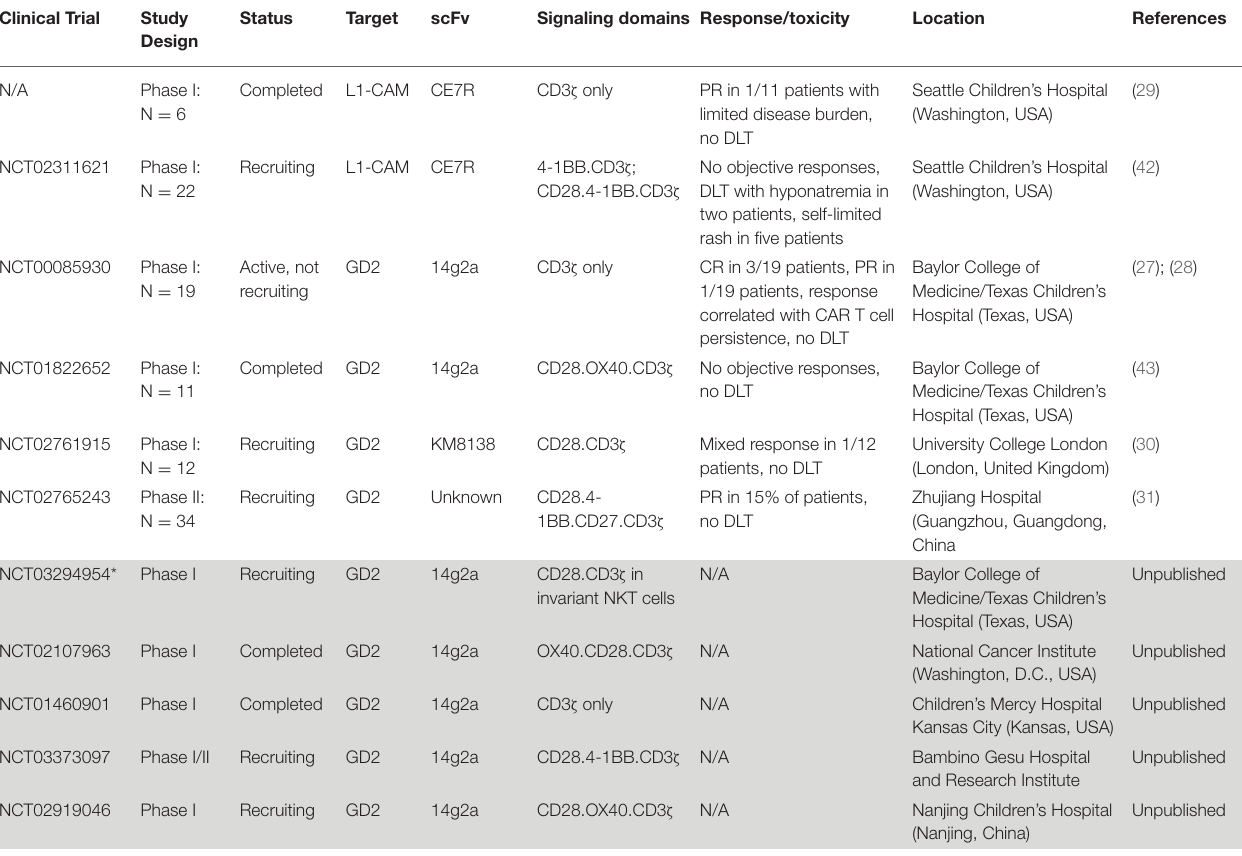
TABLE 1 | Summary of CAR T cell clinical trials for